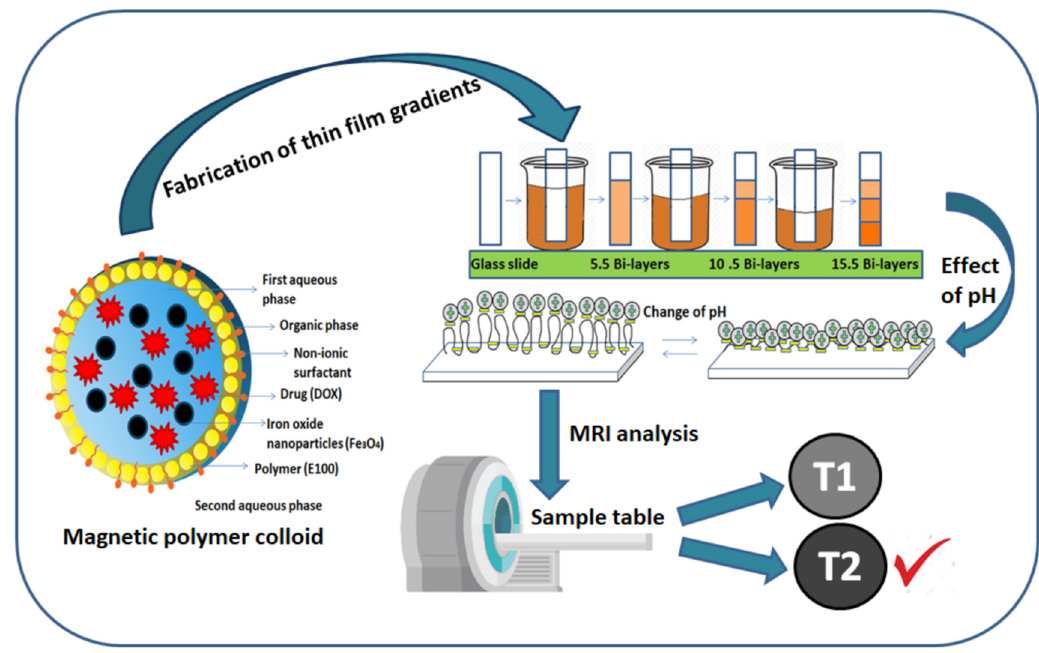
Figure 1. Schematic fabrication of magnetic polymer colloids thin film gradients and magnetic resonance imaging (MRI) diagnostics.